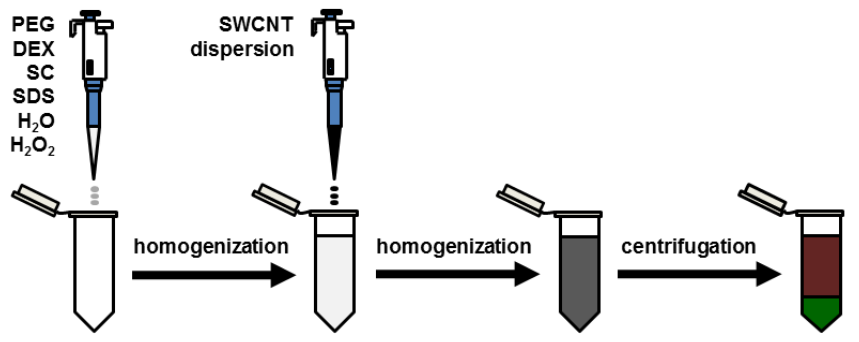
Figure 1. Sample processing methodology. The colors of the indicated phases correspond to the hues observed during the study.